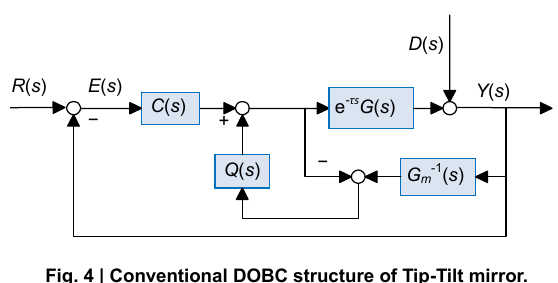
Fig. 4 | Conventional DOBC structure of Tip-Tilt mirror.